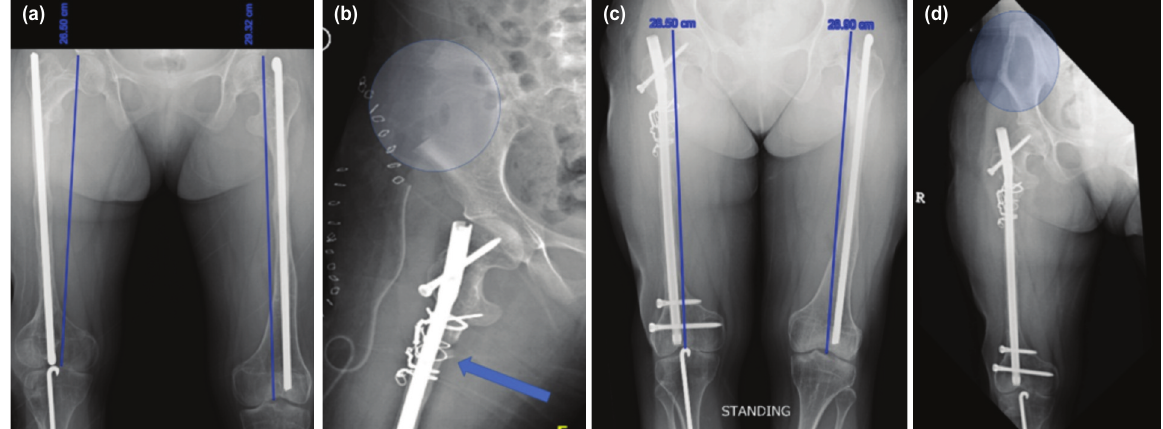
(a) Pre-operative radiograph with estimated 3cm shortening and malrotation evidence by obliquely overlapped distal femoral Fig. 2: condyle, patella facing laterally, and the fibula lies behind the tibia. (b) Post-operative radiograph showing bone graft at the subtrochanteric region stabilised with cerclage wire (arrow) with large area of tricortical graft defect (circle). (c) Post-operative radiograph with well incorporation of the bone graft with acceptable length. (d) Healing of the iliac donor site (circle) and well incorporated femur